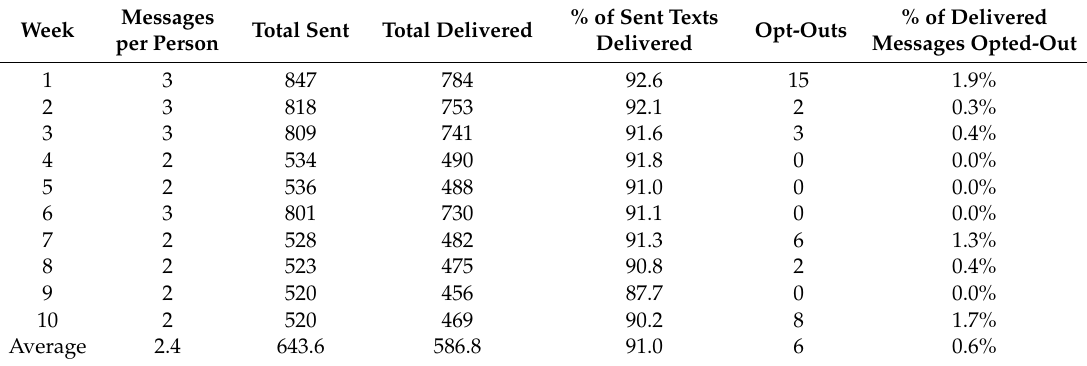
Table 3. Information messages sent and delivered during the 10-week intervention